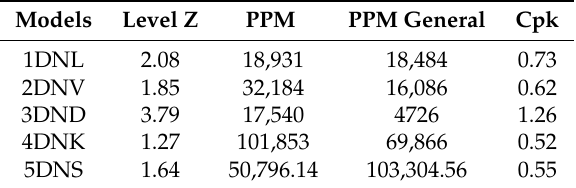
Table 13. Summary of sigma level results for each model.